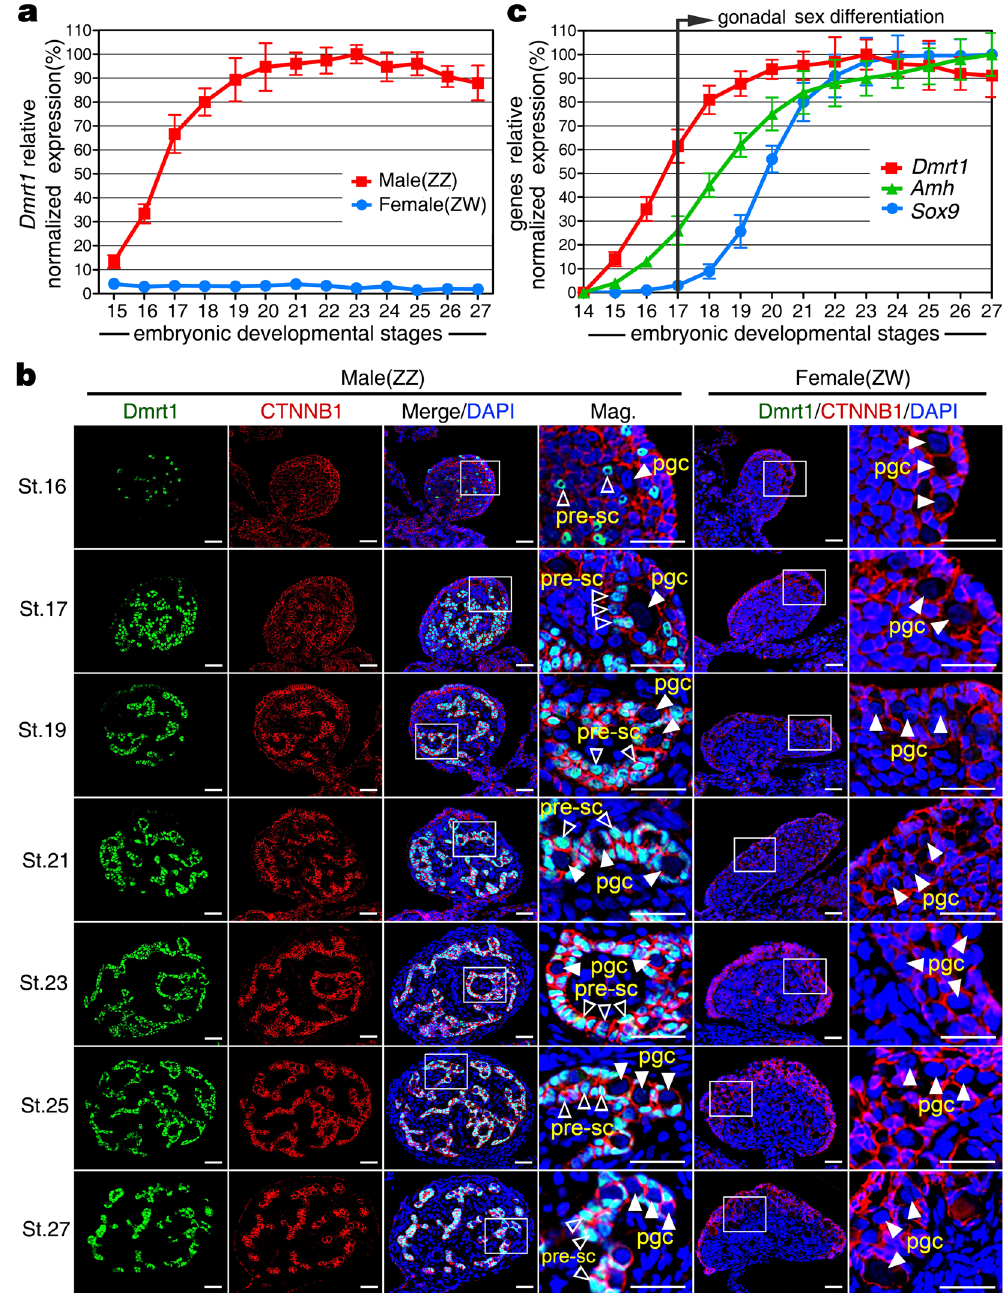
Figure 2. Dimorphic expression pattern of Dmrt1 in early embryonic gonads. ( a ) qRT-PCR showed the expression of Dmrt1 mRNA in embryonic gonads of both sexes. Dmrt1 was initially expressed in male gonads at stage 15, dramatically increased at stage 16 and then maintained at a high level from stage 20. However, extremely low level of Dmrt1 expression was detected in female gonads throughout embryogenesis. Data are shown as means ± S.D. N ≥ 3. ( b ) Localization of Dmrt1 protein in developing embryonic gonads of both sexes was performed via double immunofluorescence of Dmrt1 and CTNNB1. Dmrt1 protein was mainly localized in the nuclei of precursor sertoli cell surrounding primordial germ cells in male gonads. No Dmrt1 protein signals was detectable in female gonads throughout all time points. pre-sc, precursor sertoli cell; pgc, primordial germ cells. Scale bars are 50 μ m. ( c ) Expression patterns of Dmrt1 , Amh and Sox9 mRNA during embryogenesis were examined by qRT-PCR. Onset of Dmrt1 expression in male gonads occurred before gonadal sex differentiation, preceding Amh and Sox9 . Data are shown as means ± S.D. N ≥